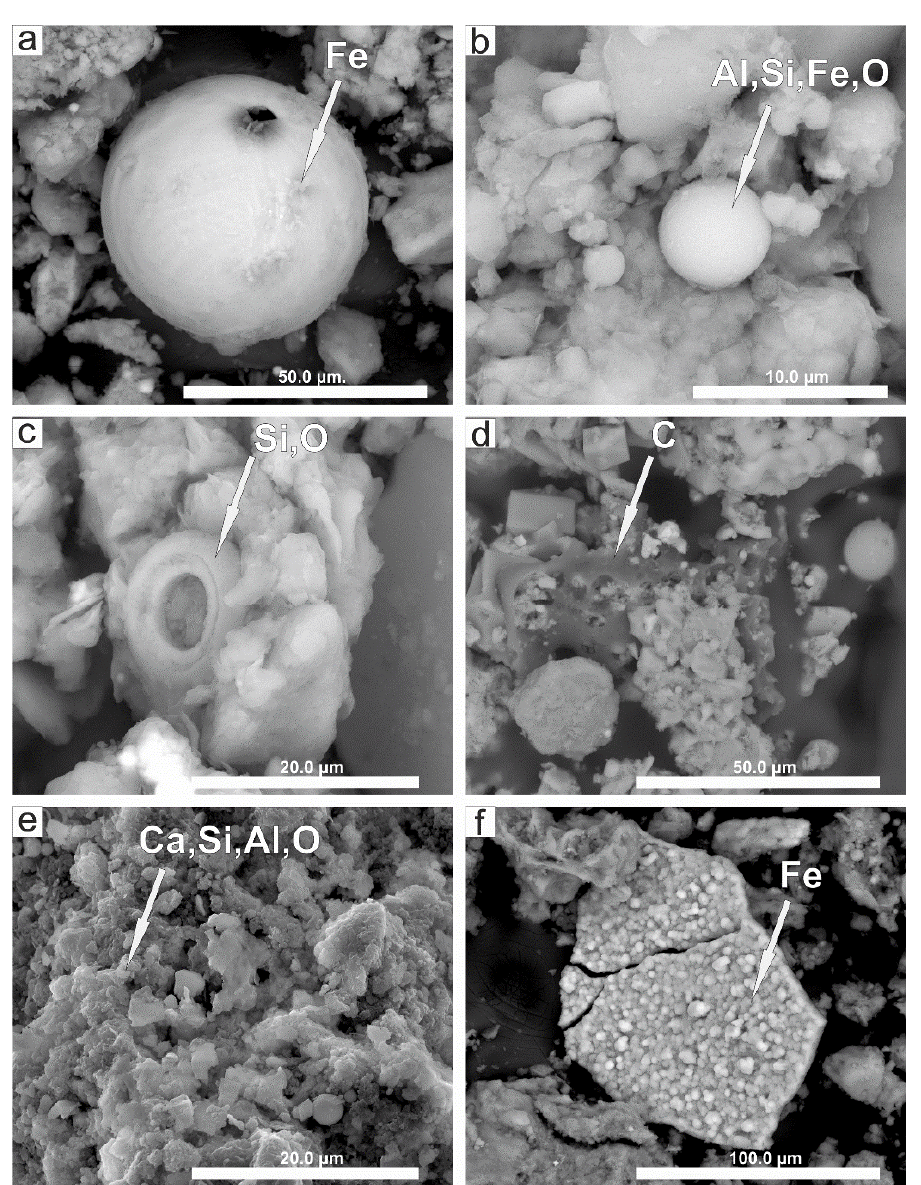
Figure 5. SEM images of individual airborne particles settled in the entrance zone. ( a ) Fe oxide spherule, E.2; ( b ) Al-Si-Fe oxide spherule, E.4; ( c ) diatom, E.2; ( d ) C-rich particle, E.2; ( e ) Ca-Al-Si-O-rich material, E.3; ( f ) ferruginous flake, E.2.